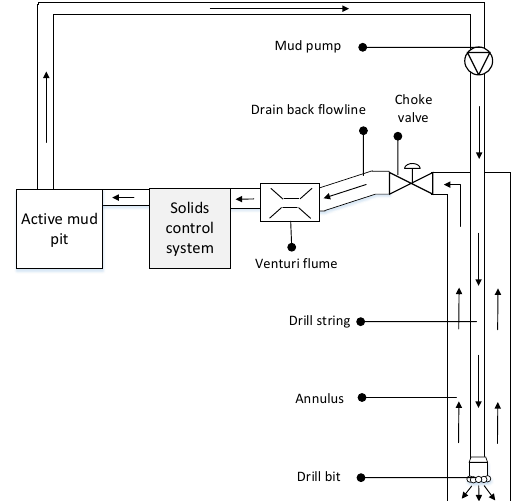
Figure 1: The schematic of a typical drilling fluid circu- lation process with the inclusion of the pro- posed Venturi